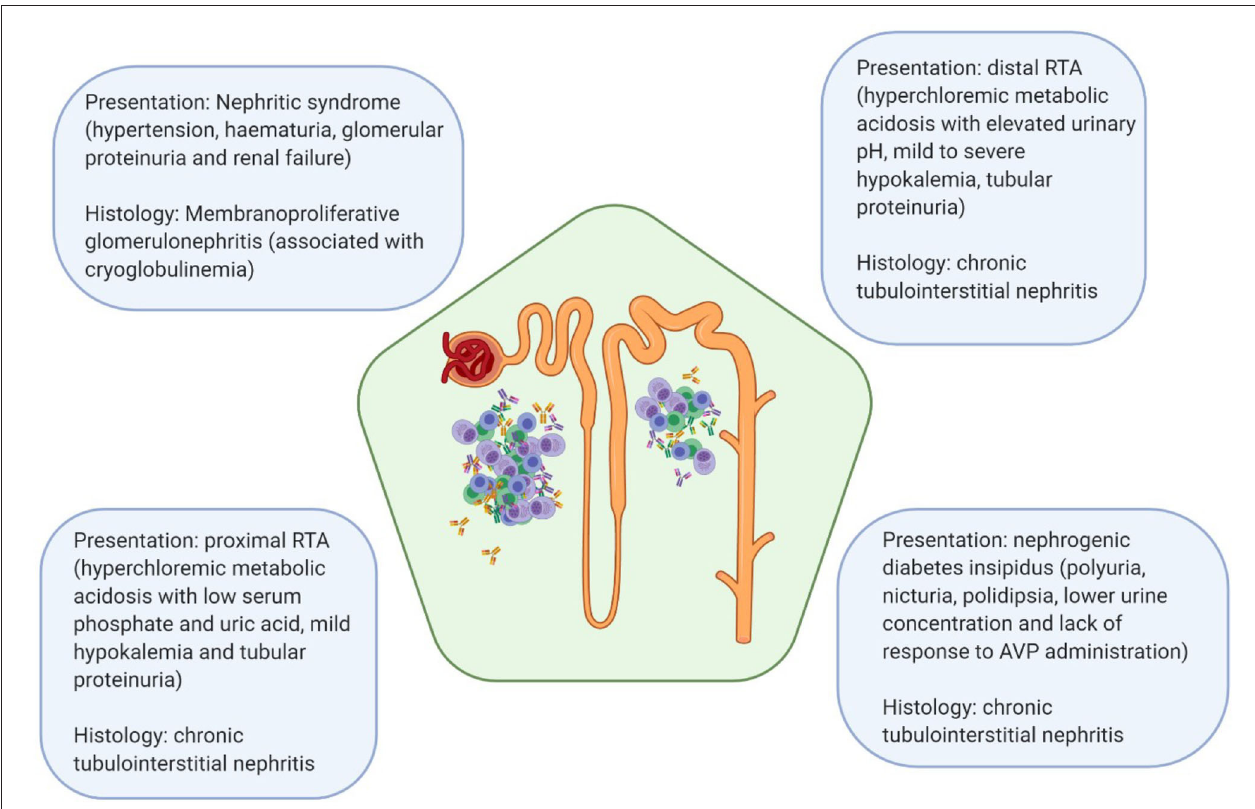
FIGURE 1 | Most common clinical manifestations of renal disease in pSS and their associated pathologic lesions. RTA, renal tubular acidosis; AVP, arginine vasopressin.